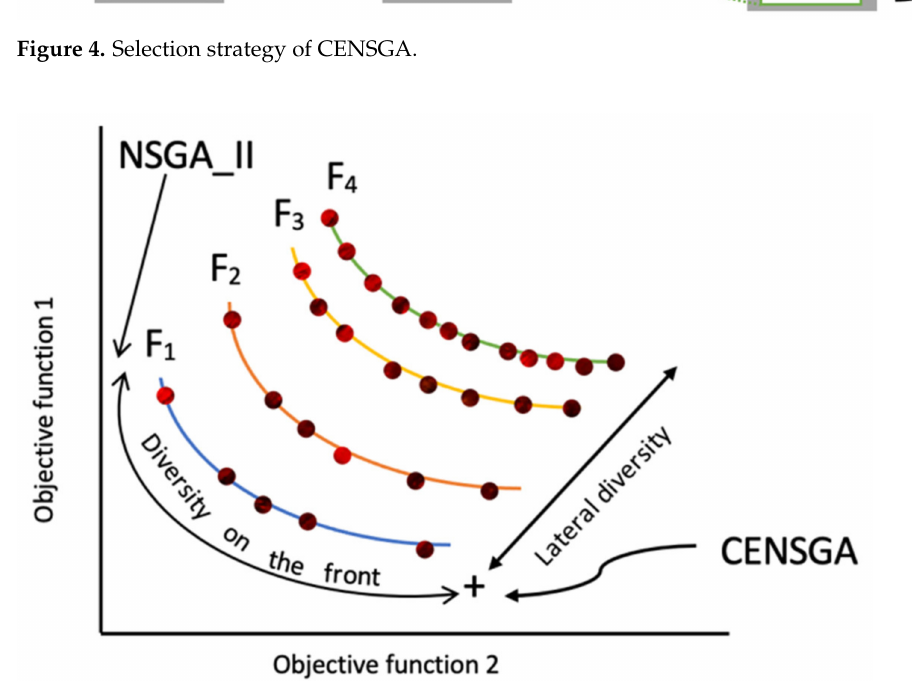
Figure 5. Controlled elitism procedure is